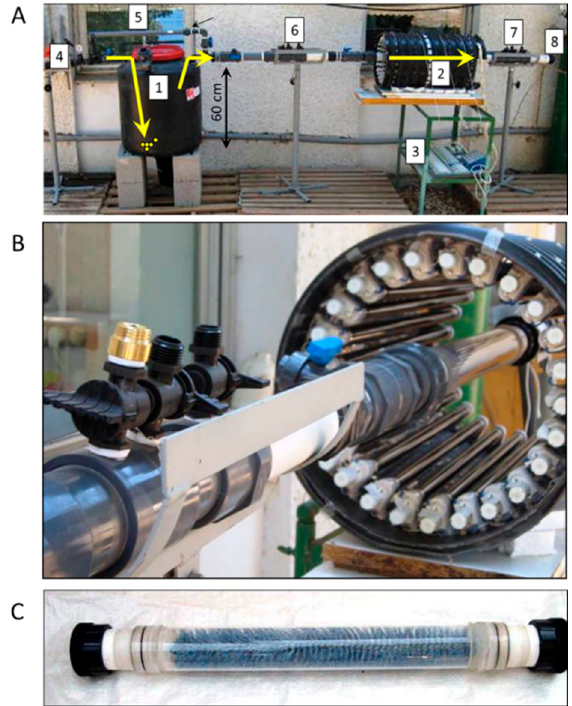
Figure 7. UV/TiO 2 photocatalysis of real poultry atmosphere. ( A ) Pilot-scale setup: 1. A 200 L tank containing 40 L of poultry manure suspension; 2. Lamp cover; 3. UV lamp control board; 4. Compressed air inlet; 5. Manure bypass; 6 and 7. Gas sampling ports (before and after treatment); 8. Exit of treated air. ( B ) A 2.5 L (2” diameter) quartz tube reactor surrounded by individually controlled 24 UV lamps. ( C ) TiO 2 -coated brush inside the quartz reactor, shown in ( B ).